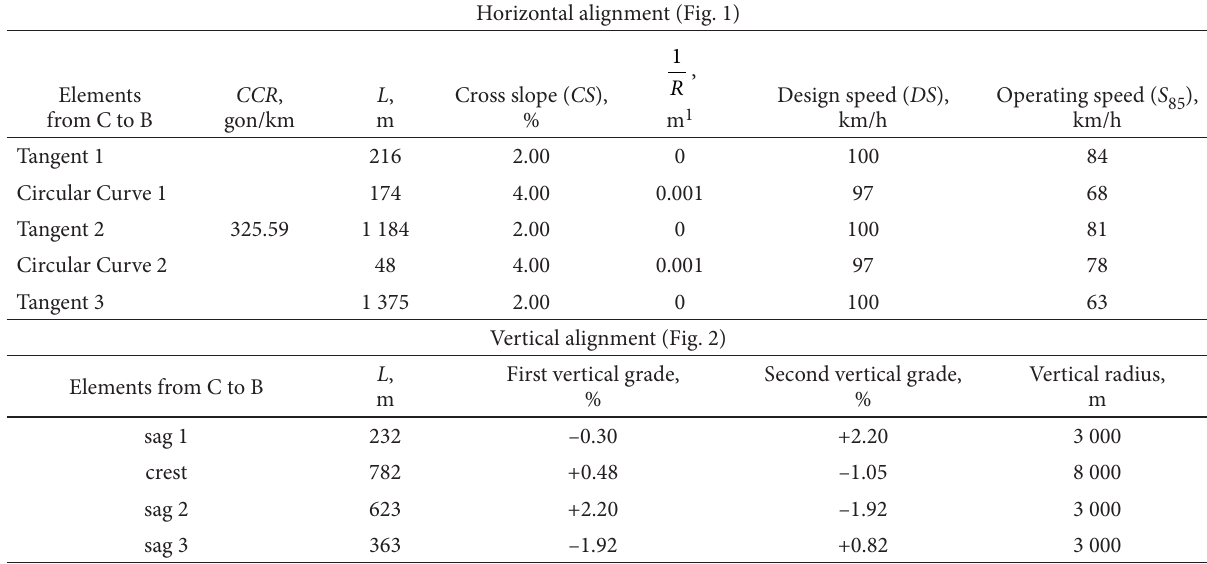
Table 1. Overview of the main geometric features of the existing study road Horizontal alignment (Fig. 1)